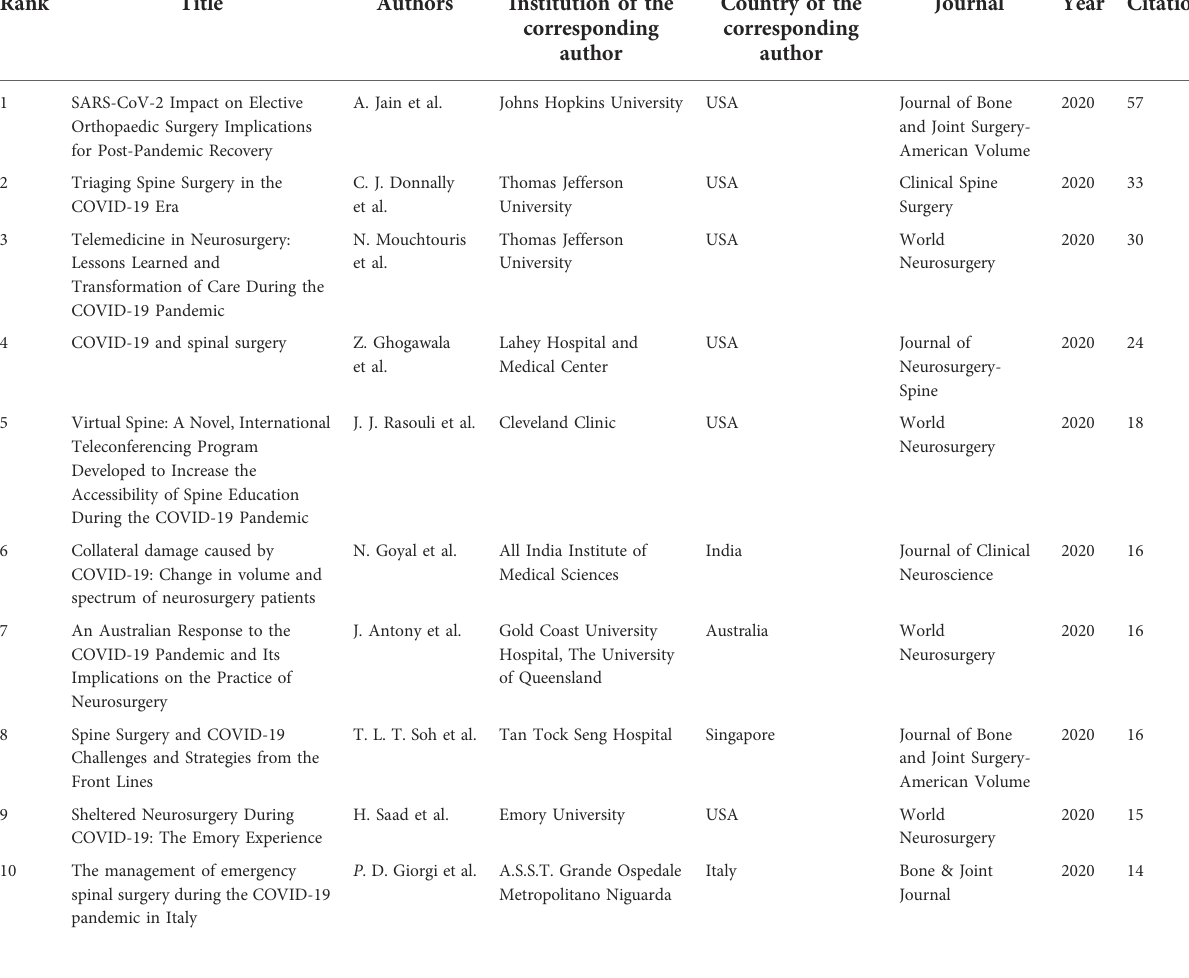
TABLE 2 Top 10 most cited articles in the fi eld of spine surgery during the COVID-19 pandemic. Rank